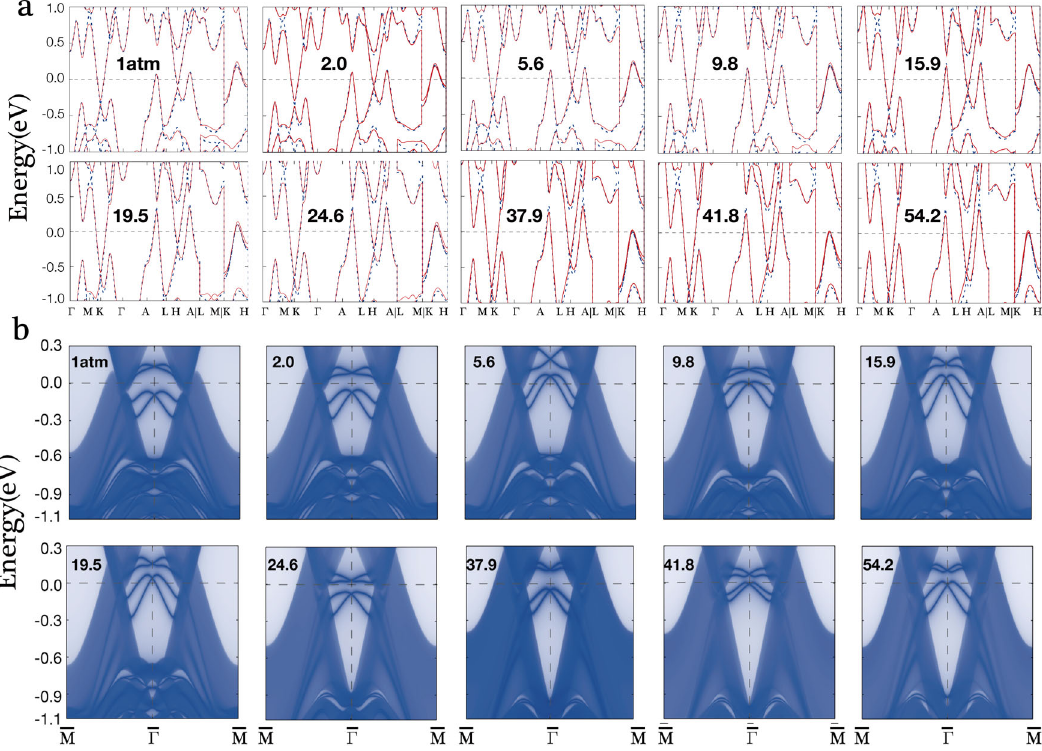
Fig. 5 Elctronic structure of Pt 2 HgSe 3 under high pressure. a Electronic structure of Pt 2 HgSe 3 in space group P 3 m 1 phase at different pressures. The blue dashed lines and red solid lines correspond to the calculations without/with SOC, respectively. b The corresponding states at (001) surface calculated from Wannier tight-binding model.